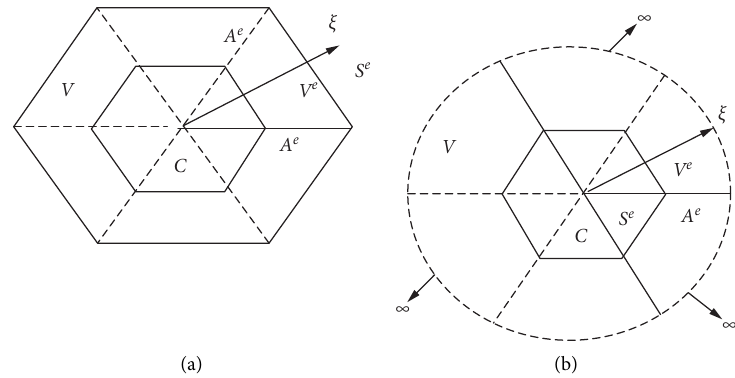
Figure 1: Cutaway view of three-dimensional saturated soil: (a) finite region and (b) unbounded media.